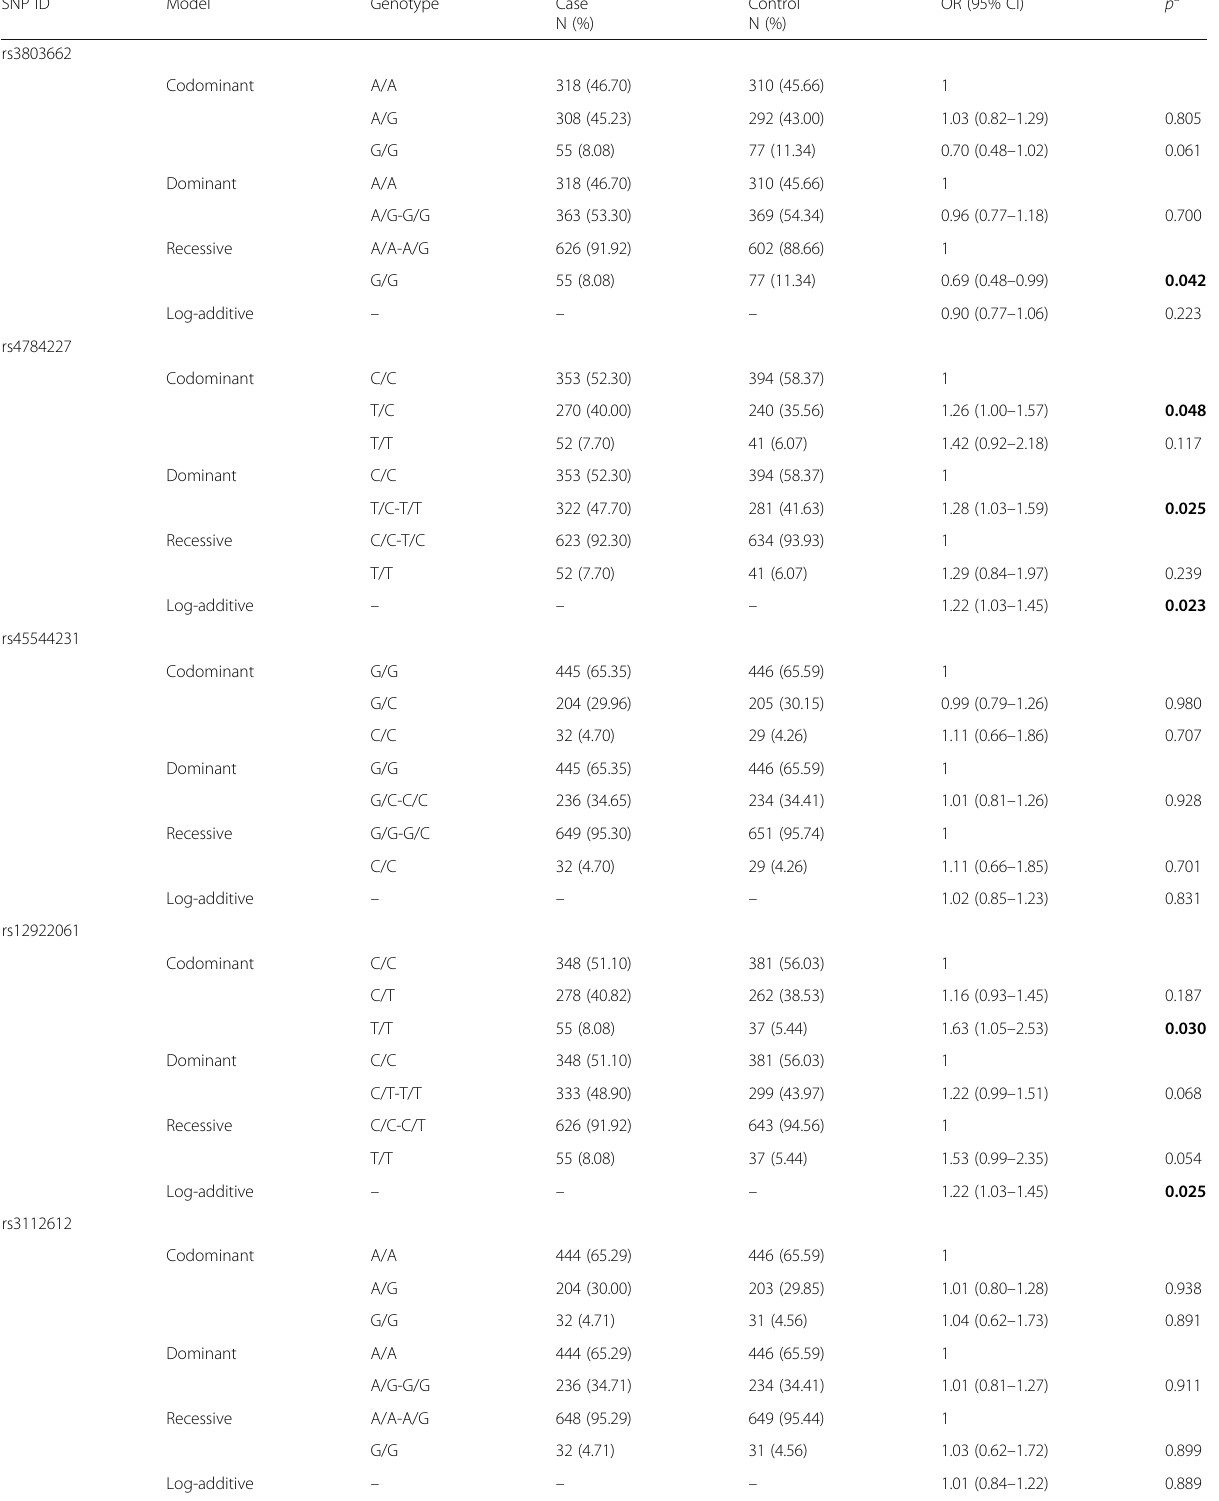
Table 3 Association between CASC16 polymorphisms and breast cancer